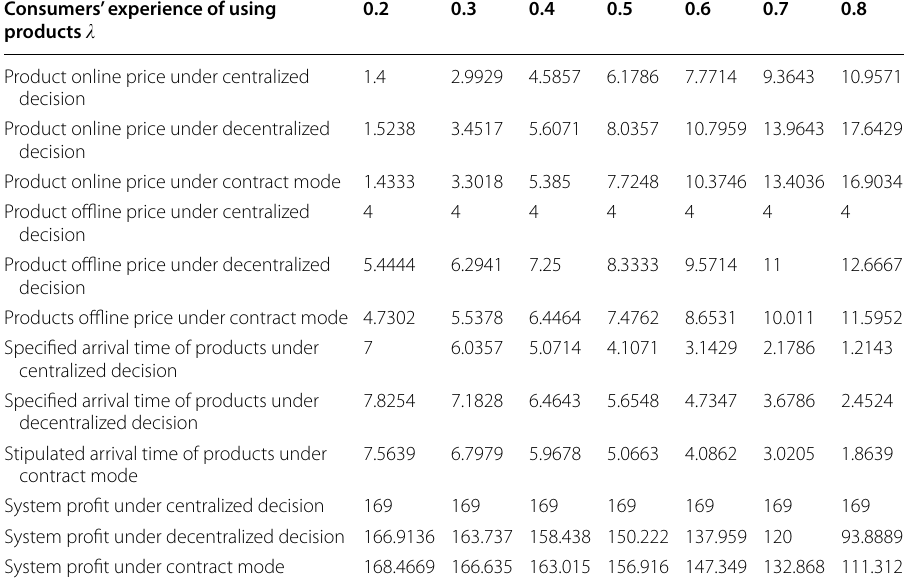
Table 2 Results of parameter changes under decentralized and centralized decision Consumers’ experience of using products